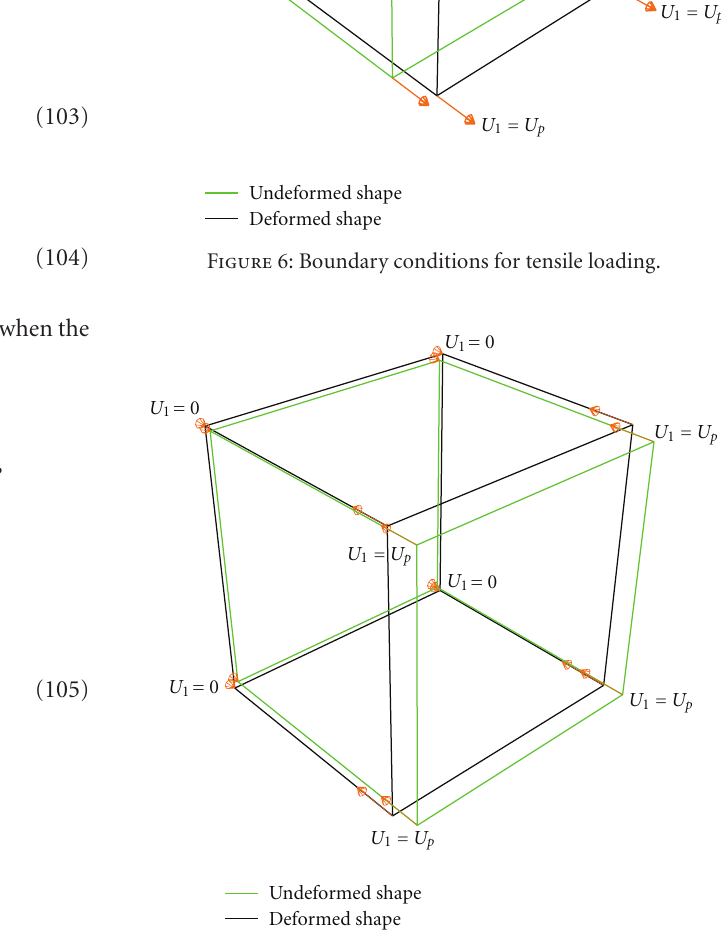
Figure 7: Boundary conditions for compression loading.